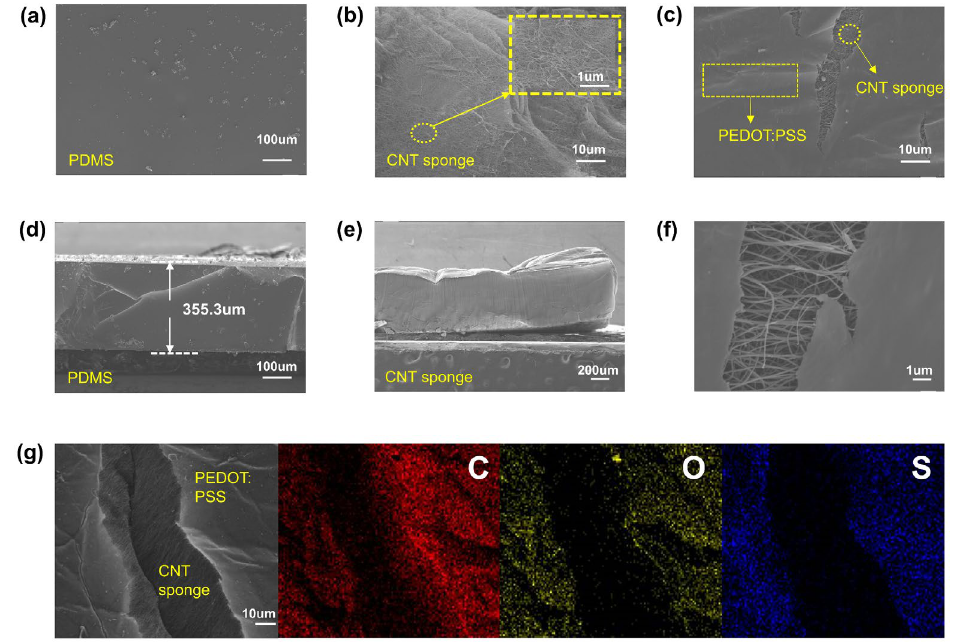
Figure 2. SEM images of the materials used in this work: ( a ) SEM image of the surface of the PDMS substrate; ( b ) SEM image of the surface of the CNT sponge; ( c ) SEM image of the surface of the CNT sponge wrapped in PEDOT:PSS; ( d ) measured thickness of the PDMS substrate; ( e ) measured thickness of the CNT sponge; ( f ) SEM image of the surface of the CNT sponge wrapped in PEDOT:PSS at higher resolution; ( g ) energy-dispersive spectroscopy (EDS) mapping images of the CNT sponge wrapped in PEDOT:PSS.